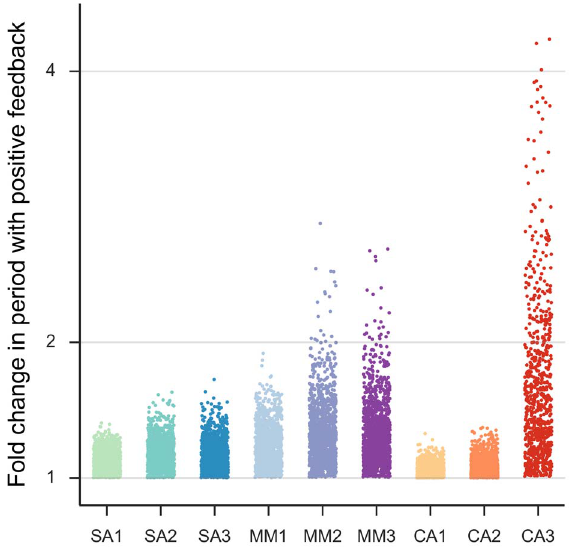
Figure 4. Period of oscillations for the core motif versus the positive feedback motifs. The ratio of the period of the positive feedback motif and period of the core motif for different choices of parameter values categorized by class: SA, MM and CA.